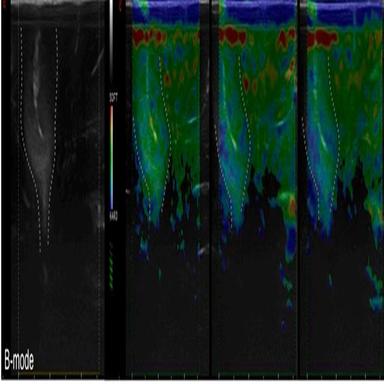
comparison between B-mode ioUS (on the left) and SE images (on the right). At high frequencies grey scale image, the FCD appeared as a faint hyperechoic area (delimited by light grey dotted lines). Multiple small areas of stiffer parenchyma (blue dots) are visible within the thickened cortical layer, which remained stable during all three evaluations. Other areas of stiffer parenchyma within FCD are visible only on some of the SE evaluations. On the contrary, adjacent healthy brain tissue did not demonstrat